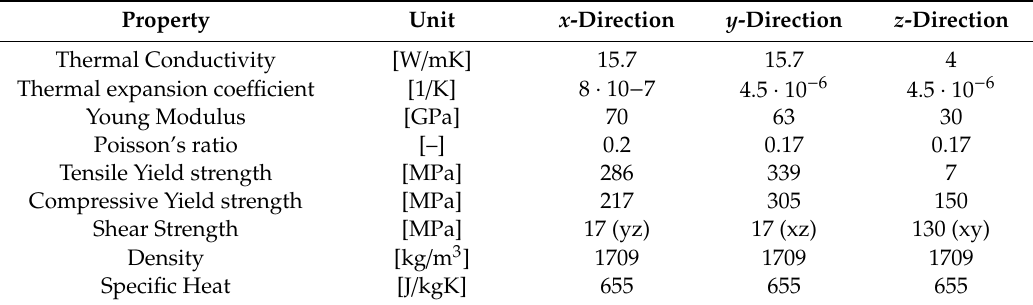
Table 3. C/SiC thermal and mechanical properties.